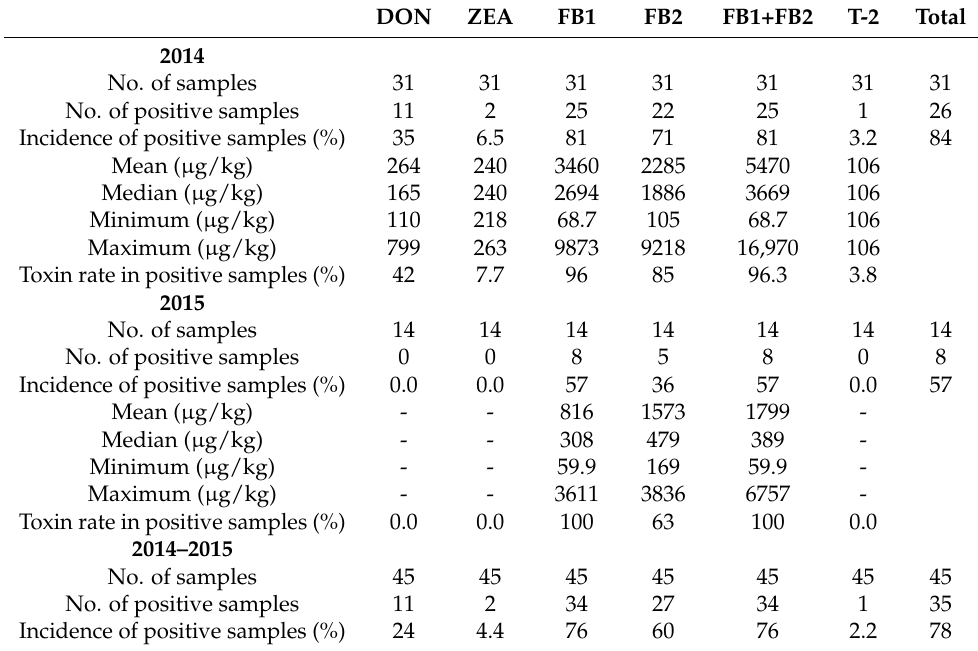
Table 2. Occurrence of Fusarium toxins in maize samples from the harvesting seasons 2014 and